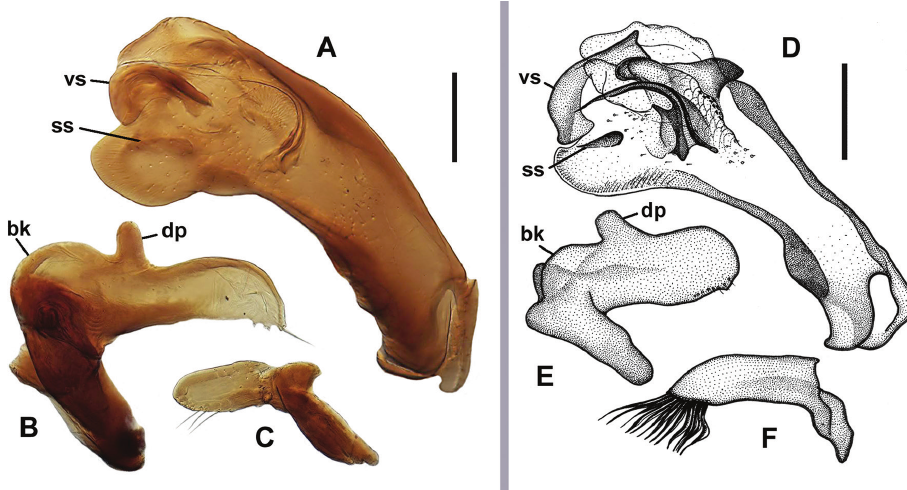
Figure 4. Digital images and line drawings of male genitalia of Anillinus species. A. relictus (E of One- onta, Blount County, Alabama) A median lobe, right lateral aspect B left paramere, left lateral aspect C right paramere, right lateral aspect. A. sinuatus (Bexar County, Texas) D median lobe, right lateral aspect E left paramere, left lateral aspect F right paramere, right lateral aspect. bk – basal keel, dp – dorsal process, ss – spine-like structure, vs – ventral sclerite. Scale bars: 0.1